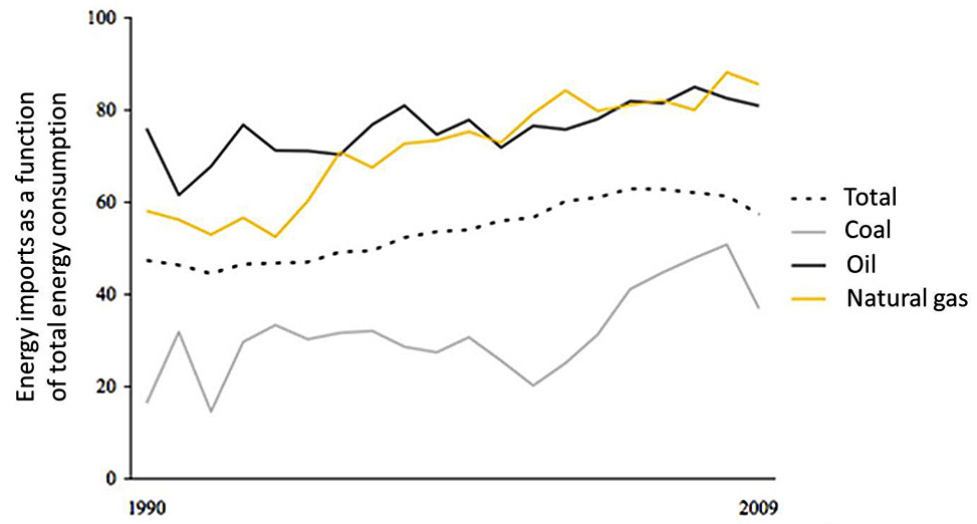
Figure 1. Hungary’s dependence on energy imports [46].